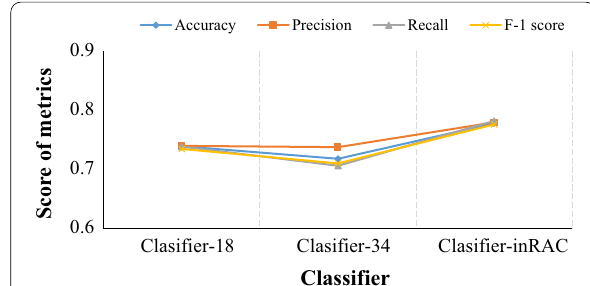
Fig. 9 Classfication performance comparison between different classifiers in Table 7